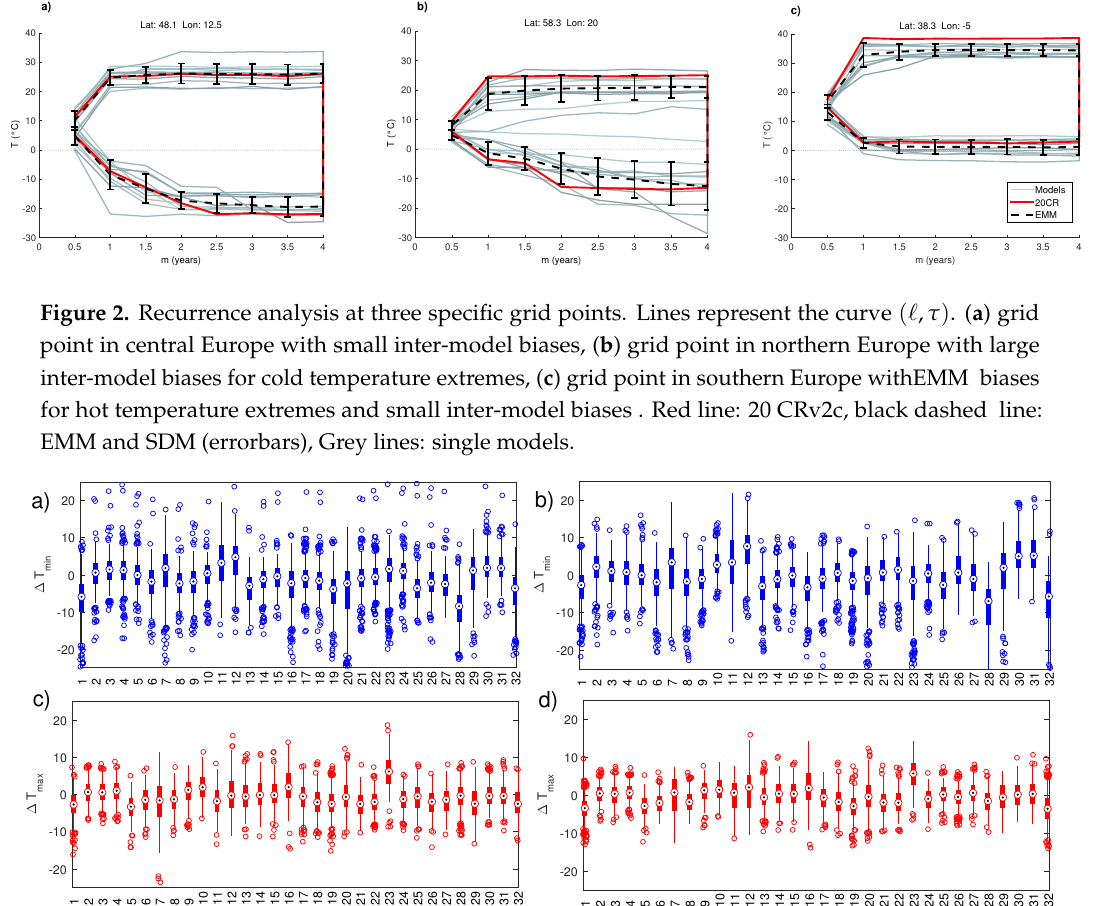
Figure 3. Box plots of the biases in T min ( a , b in blue) and T max ( c , d in red) between models and 20CRv2c in 1900–1999. Numbers in x-axis correspond to CMIP5 models ordered from highest to lowest resolution. Central marks are the median, the edges of the box are the 25th and 75th percentiles, the whiskers extend to the most extreme data points not considered outliers, and outliers are plotted individually. Different bin length m are represented: 1 year ( a , c ) and 4 years ( b , d ). Detailed statistical information about this figure in Table